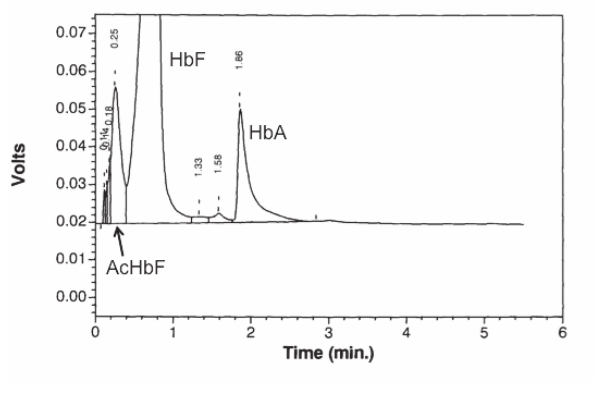
Figure 3. Correlation between fetal hemoglobin (HbF) and HbA measured at birth.